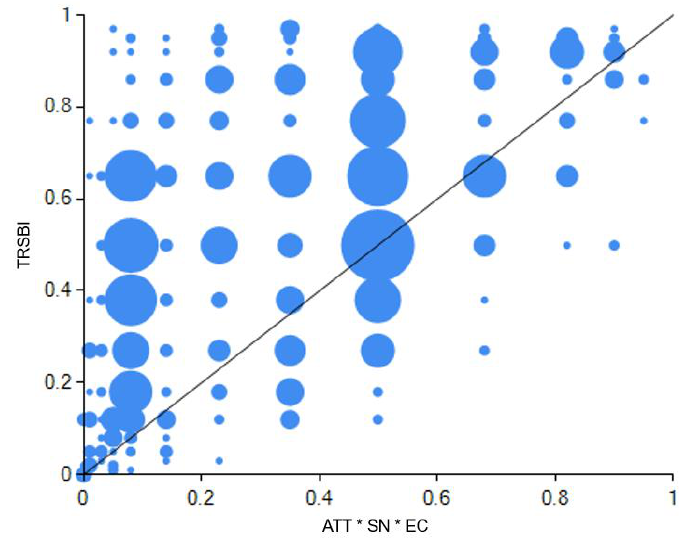
Figure 4. Configuration 2 explanation in the mode of tourist resource-saving behavioral intentions.